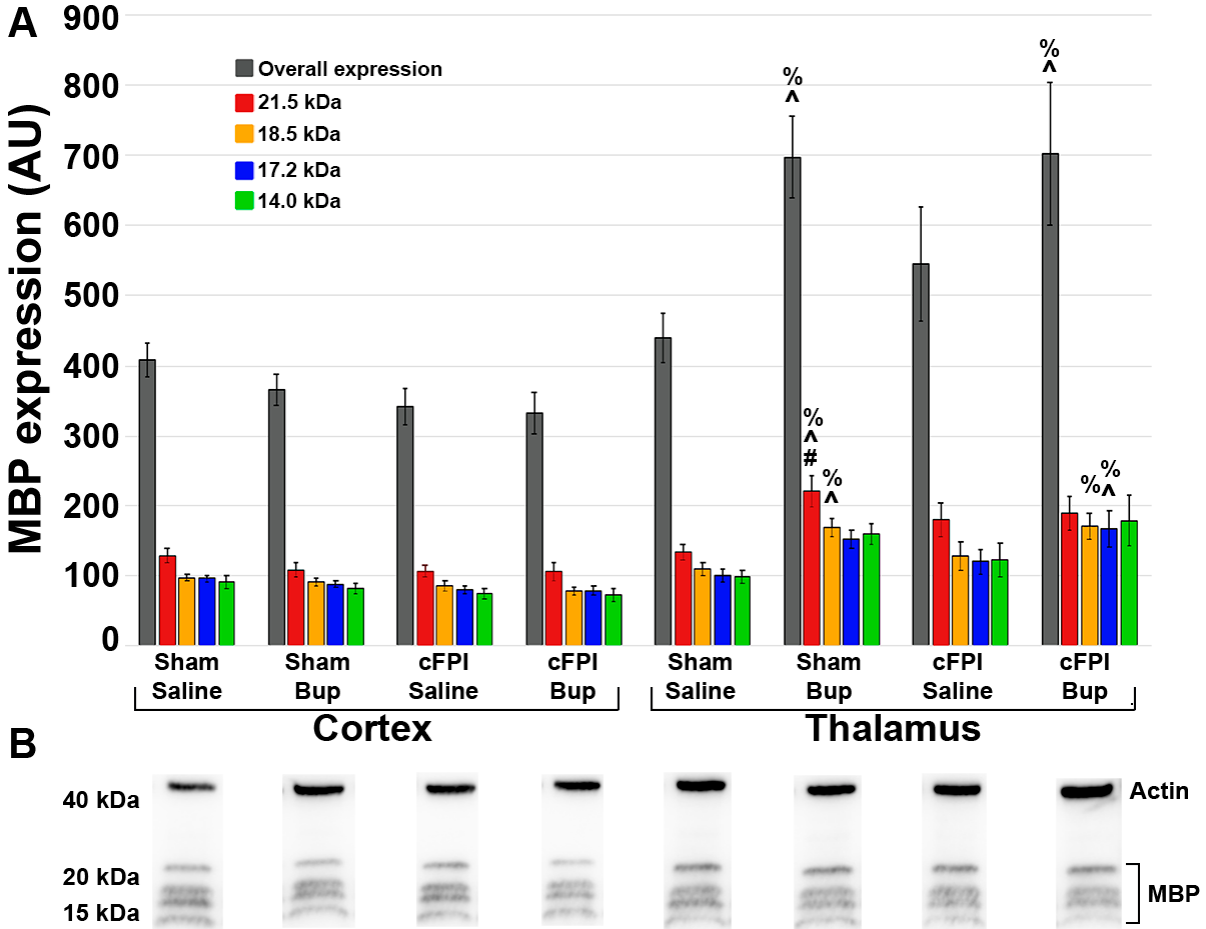
Figure 7. Expression of MBP was altered in a region-specific as well as a drug-and-region related manner at 4 weeks post-injury. ( A ) Bar graph depicting average overall MBP expression (gray bars), as well as expression of 21.5 kDa (red bars), 18.5 kDa (orange bars), 17.2 kDa (blue bars), and 14.0 kDa (green bars) MBP isoforms in the cortex and thalamus of saline and Bup treated animals following sham or cFPI injury. ( B ) Representative Western blots of actin (band at ~40 kDa) and MBP (bands at ~15–20 kDa). n = 6 rats/group. Mean ± SEM. # p < 0.05 compared to sham Bup cortex, ^ p < 0.05 compared to cFPI saline cortex, % p < 0.005 compared to cFPI Bup